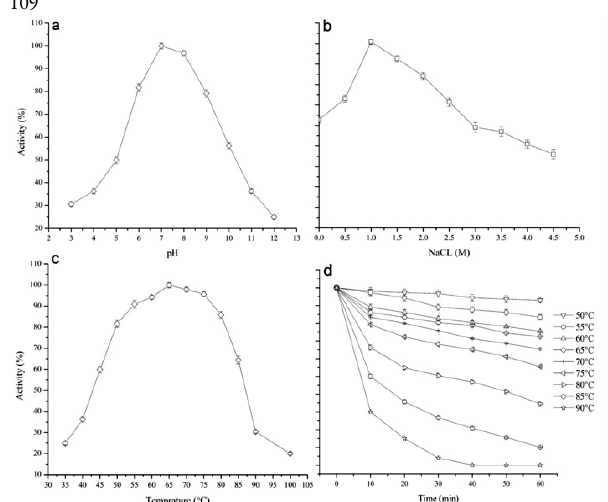
Fig. 4. Effect of NaCl ( a ), pH (b) and temperatures ( c and d) on the activity of the amylase. Relative activity was defined as the percentage of maximum activity detected in the assay.